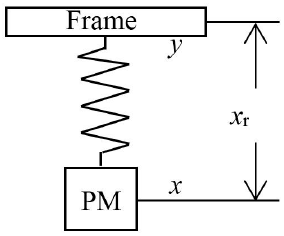
Figure 1. Schematic of spring accelerometer.